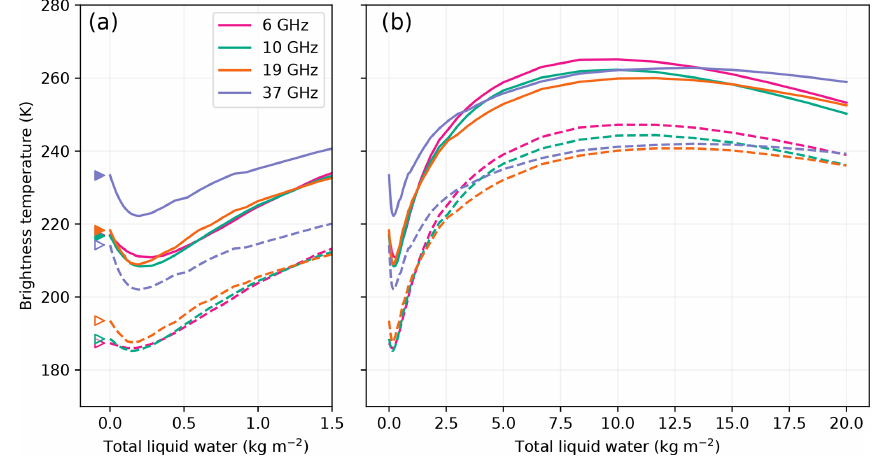
Figure 9. Brightness temperatures at Roi Baudouin at V-pol (solid curves) and H-pol (dashed curves) computed with the permittivity for- mulation from Hallikainen et al. (1986) featuring a low imaginary part as a function of the total liquid water content ( a , zoomed in; b , full range). The dry brightness temperatures are marked by the triangles.